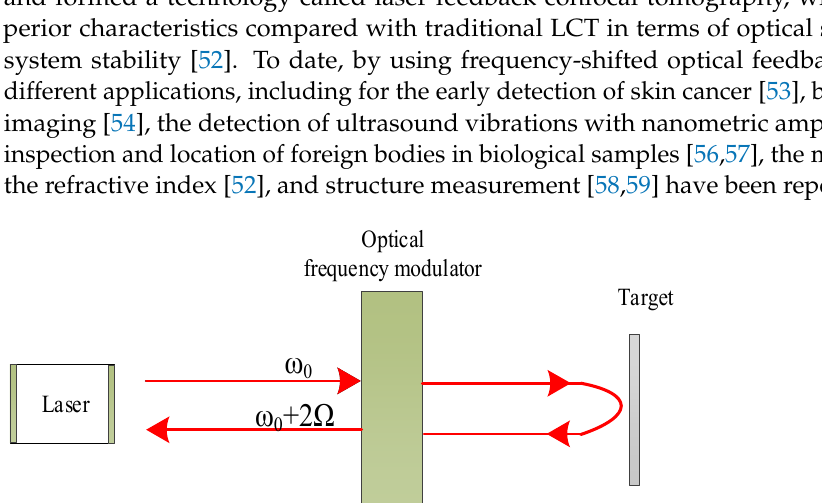
Figure 6. The basic structure a frequency-shifted feedback system, where ω 0 is the laser frequency, Ω is the frequency shift of the modulator.